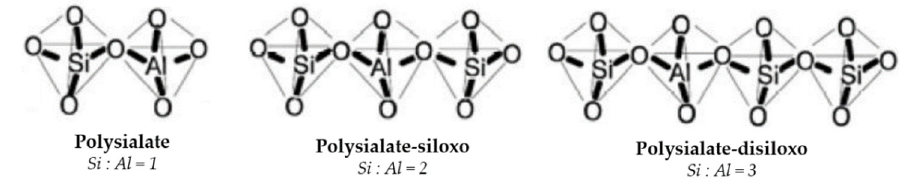
Figure 4. Chemical structures of polysialates.